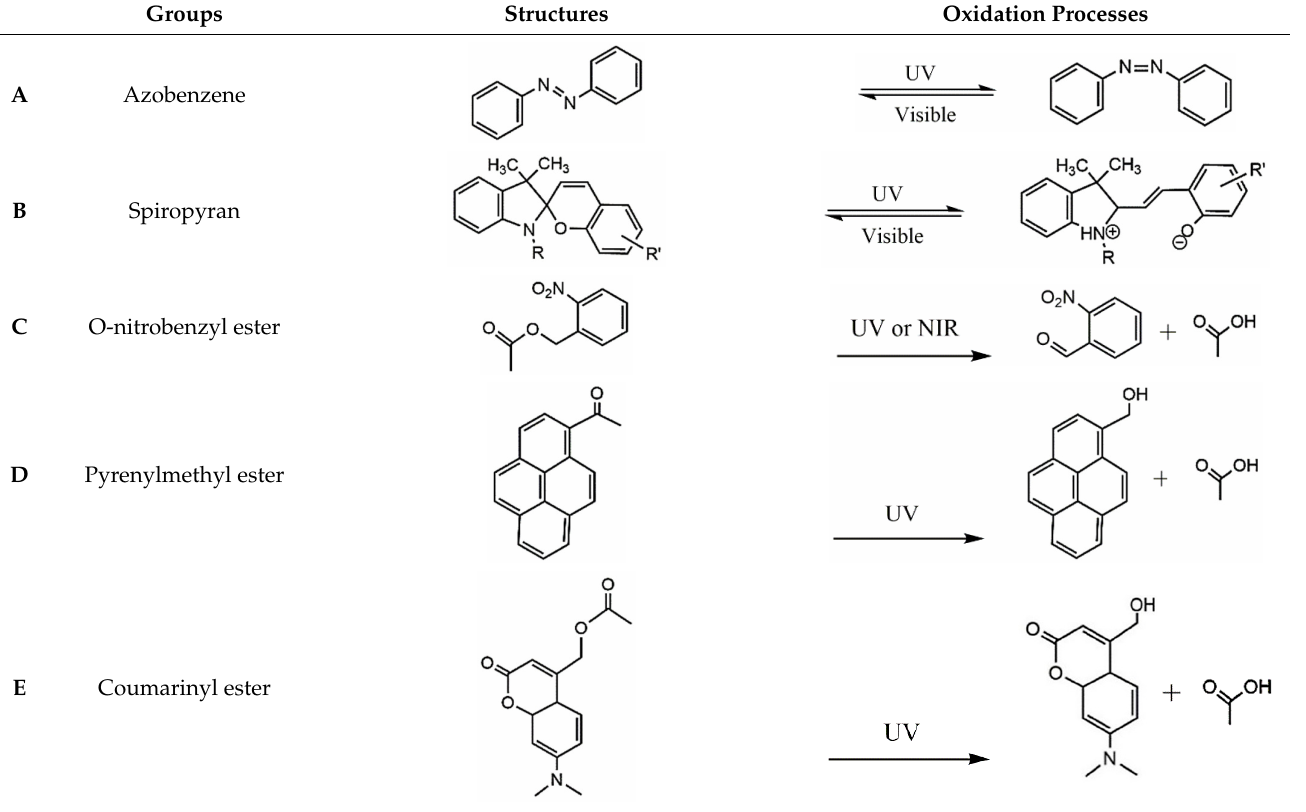
Table 1. Groups, structures, and oxidation processes of the PAMs [127,136]. Groups